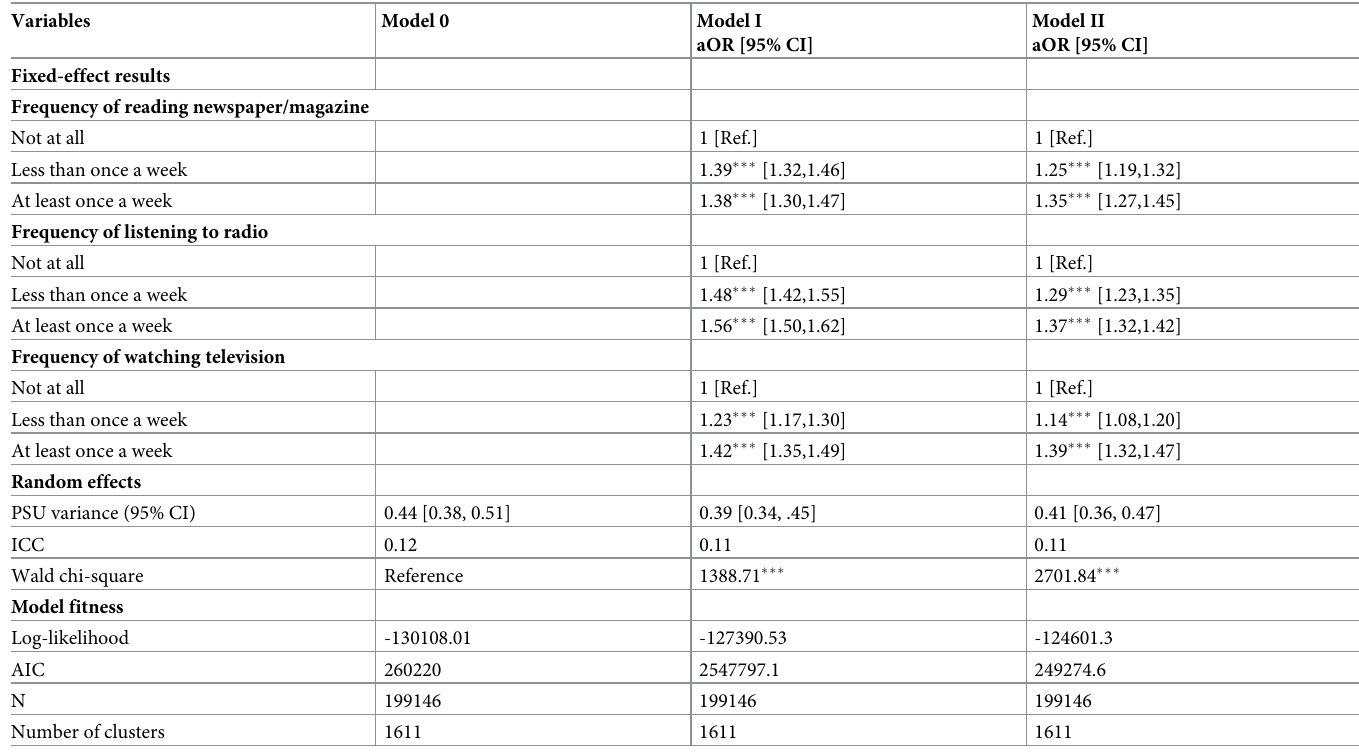
Table 5. Fixed and random effect results of the association between mass media and